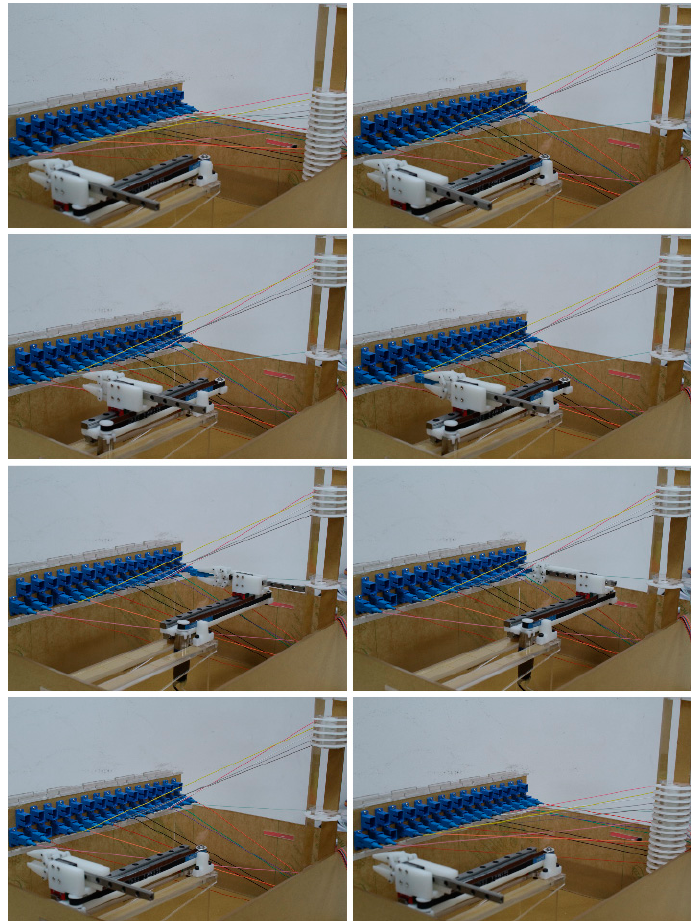
Figure 20. Cross-connect process of a random sequence.